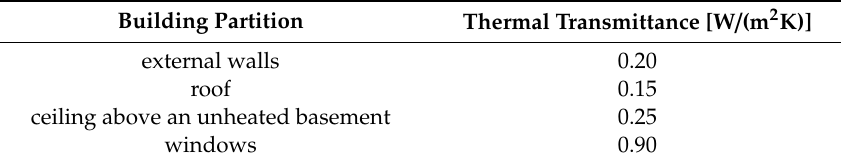
Table 3. Polish technical requirements involving thermal transmittance for multi-family buildings